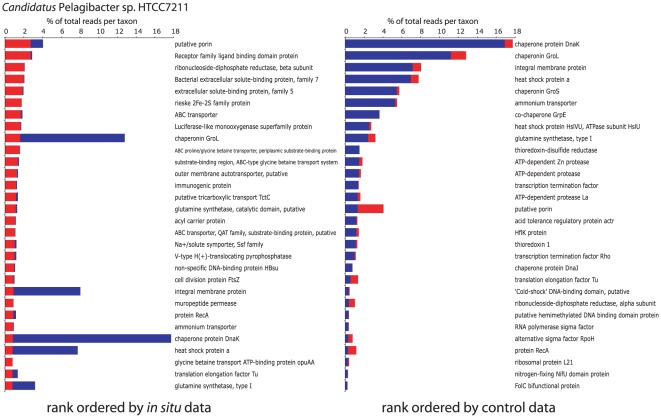
Thirty most abundant genes matching Candidatus Pelagibacter sp. HTCC7211 recovered in metatranscriptomes from Experiment B.Abundances are expressed as percentages of the total number of reads with top matches to this genome (identified vi BLASTX against the nr database). Genes are ranked by abundance in the in situ (left, red) and control (blue, right) datasets.